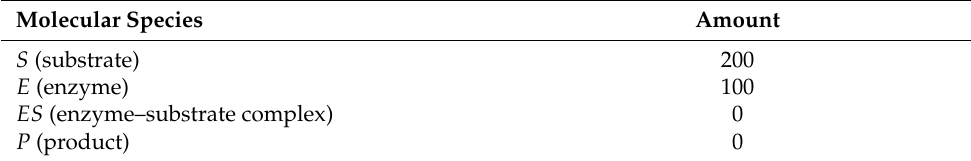
Table 1. Initial state of the MM